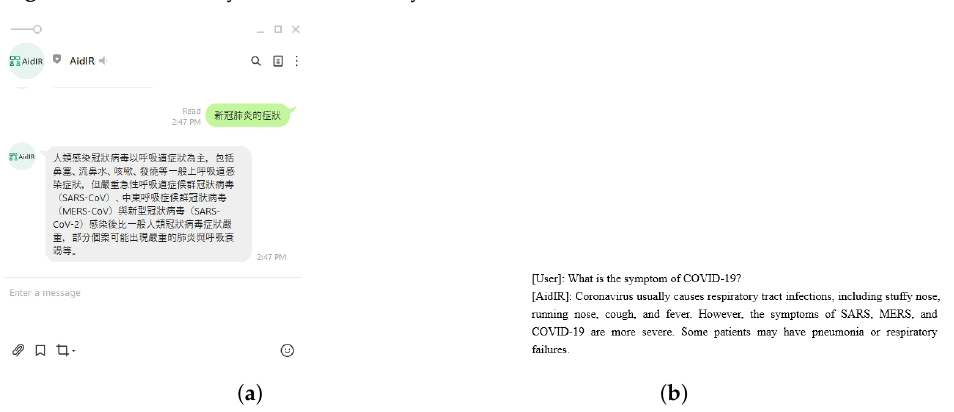
Figure 8. Results of keywords search in systems with GUI.